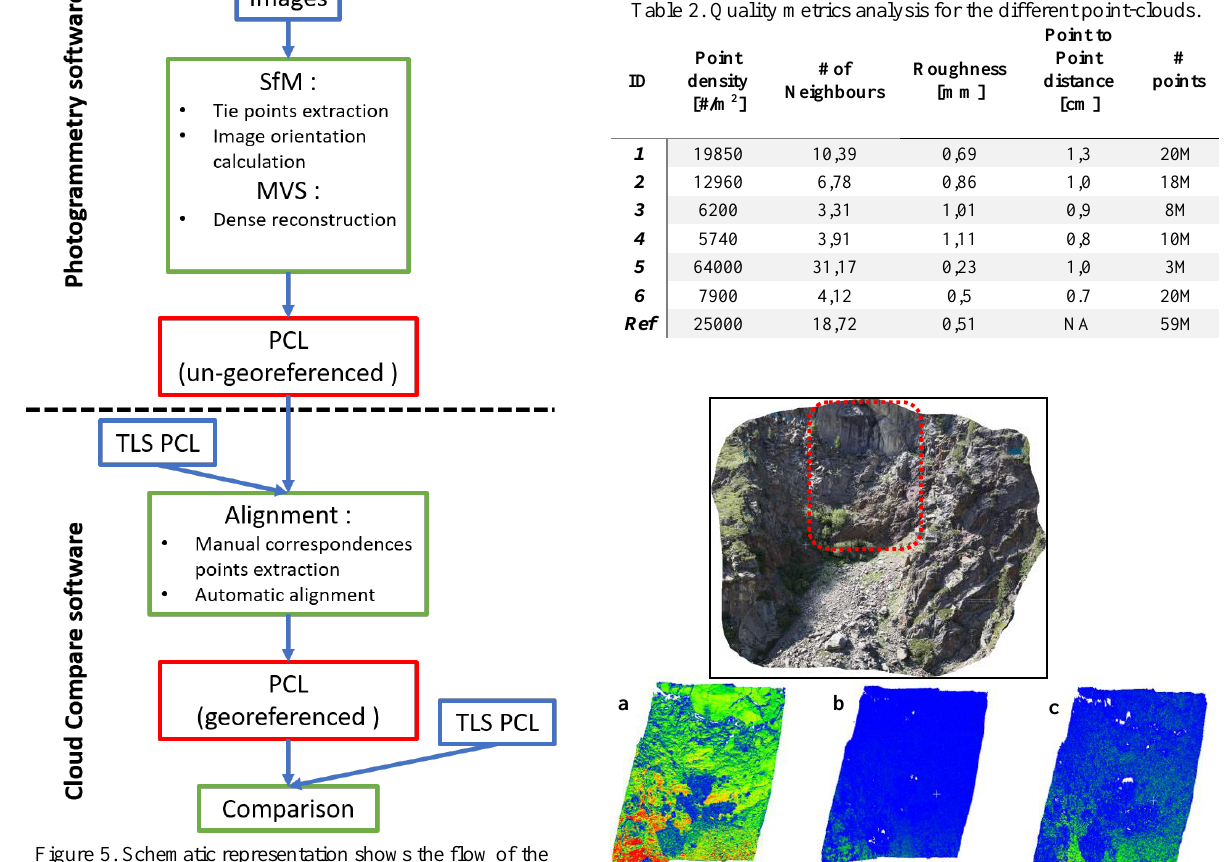
Figure 5. Schematic representation shows the flow of the proposed methodology.